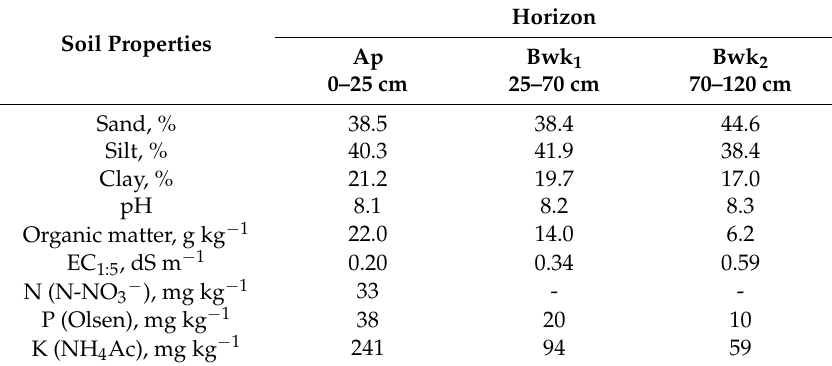
Table 2. Soil properties at the beginning of the experiment (2003).